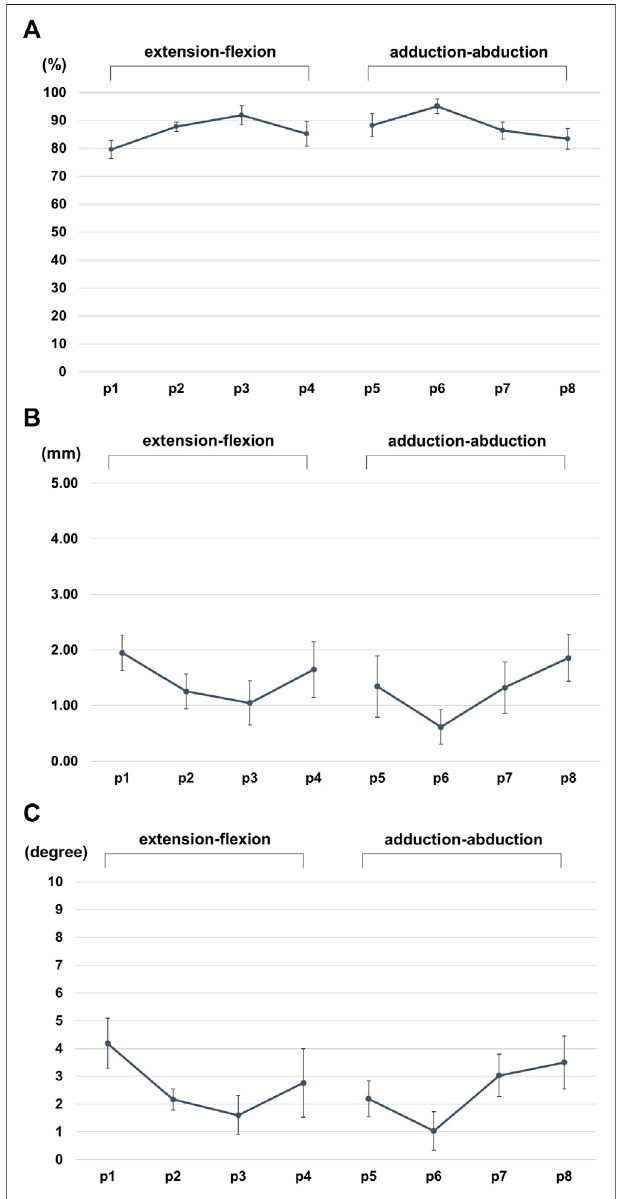
FIGURE 5 | (A) Volume matching portion (%) of the metacarpal before and after arthroplasty. (B) the difference in the centroid (mm) of the metacarpal. (C) Angle change (degrees) of the metacarpal bone axis before and after arthroplasty.